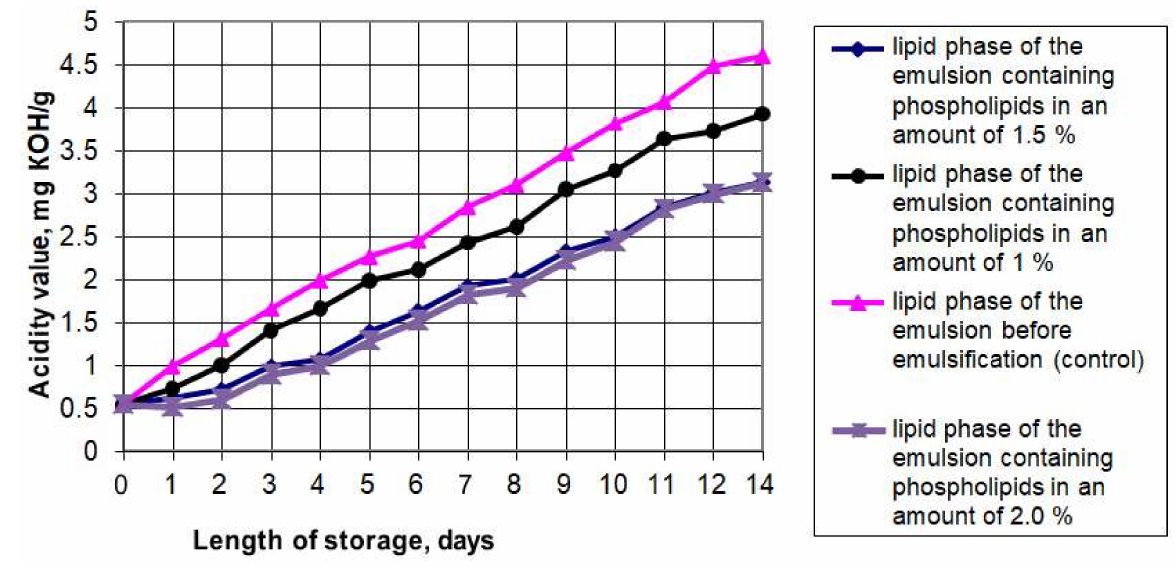
Figure 2. The acid number of the phospholipid emulsions during accelerated oxidation. The graphs show that the peroxide number (PV) of the emulsion lipid phase without phospholipids increased from 1.5 to 15.9 mEqO 2 /kg. The peroxide number of the emul- sion’s fat phase with 1% phospholipids added increased from 1.5 to 13.1 mEqO 2 /kg in two weeks of storage under accelerated oxidation conditions. The samples containing